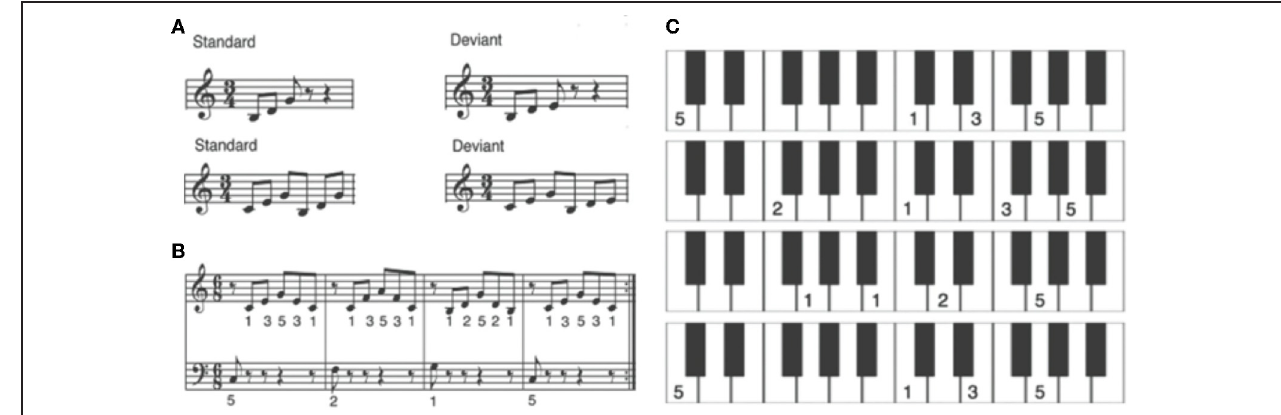
FIGURE 2 | ( From Lappe et al., 2008 ). (A) Tone sequences for the standard and deviant stimuli that were used in the MEG measurements before and after training. (B) Musical score of the I–IV–V–I chord progression in c-major in broken chords that was used as a training sequence for SA and A training. (C) Visual templates for the SA training for each broken chord of the training